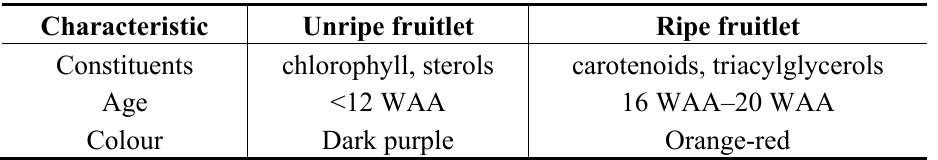
Table 2. Characteristics of oil palm